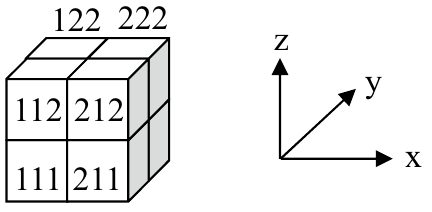
Fig. 6 Illustration of a 4-room system with a Cartesian coordinate (the following illustrations are placed in the same coordinate sys-